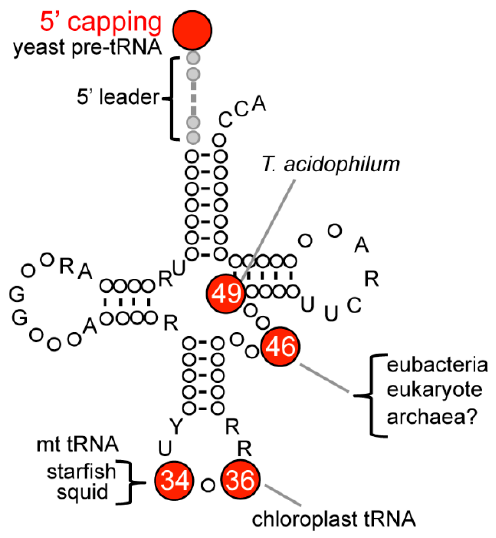
Figure 2. Positions of the m 7 G modification in tRNA. The numbers in circles indicate the positions of m 7 G in tRNA.